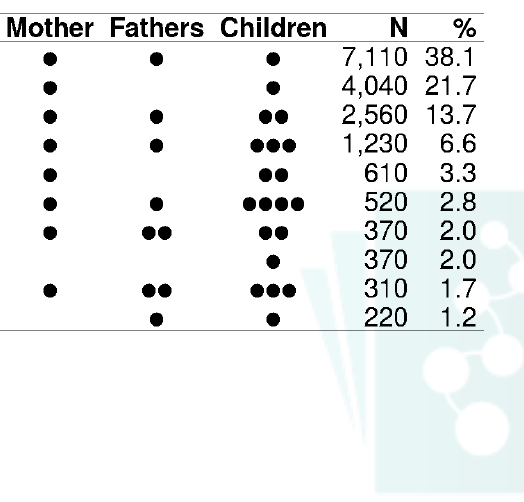
(b) Top 10 most frequent family compositions in